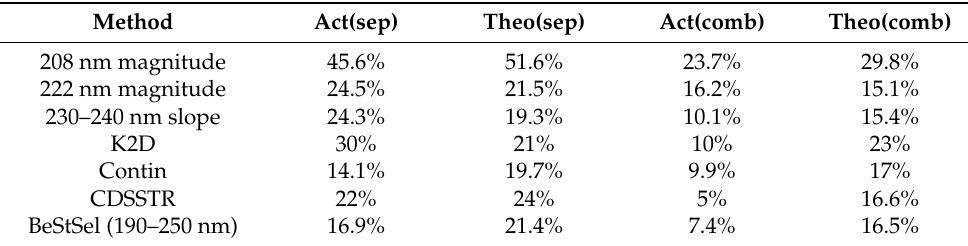
Table 2. Helical Prediction for LMMWYR by Various